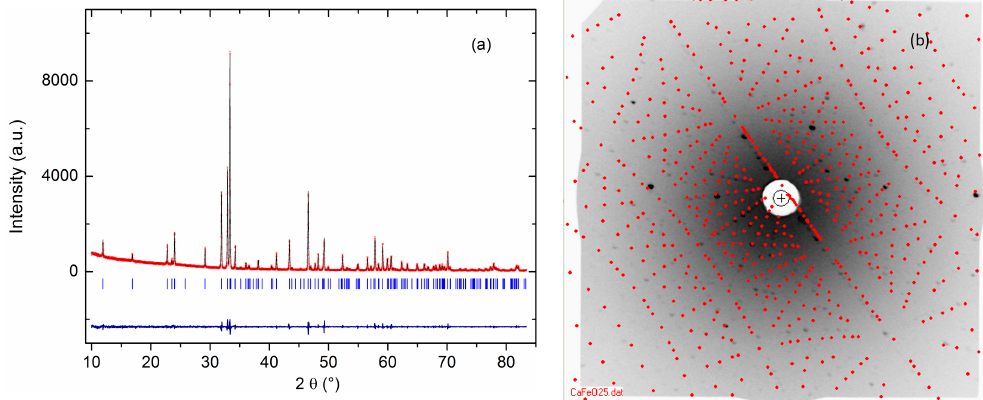
Figure 8. ( a ) Observed, calculated, and difference plots of XRD (Bruker D8 Advance, Cu K α 1 ) patterns of the as-grown single Ca 2 Fe 2 O 5 crystal in the Pnma space group, obtained in profile matching mode. Vertical bars are related to the calculated Bragg reflection positions; ( b ) X-ray Laue back diffraction pattern taken on the middle of the cross-section of the crystal, showing the [101] growth direction (as obtained by OrientExpress).